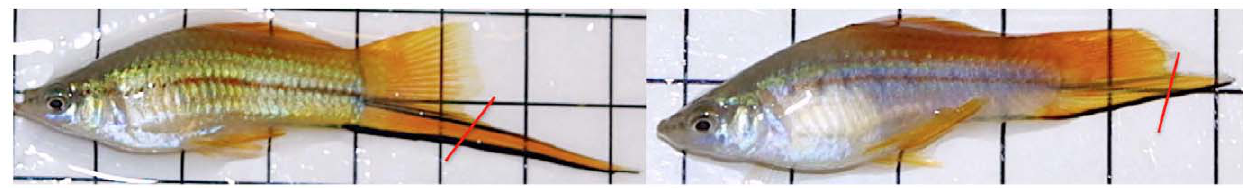
Figure 2. Variation in sword length. Two X. helleri males used in our study; one displaying an exceptionally long sword (left) and the other a very short sword (right), despite similar body lengths. Swords were removed at the point where the sword extends beyond the caudal fin, as indicated by the red lines.